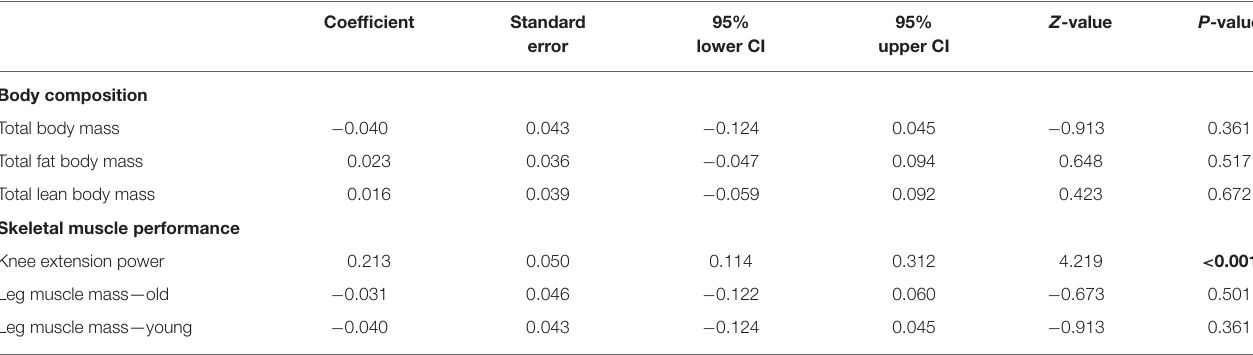
TABLE 2 | Meta-regression for bed rest duration and observed